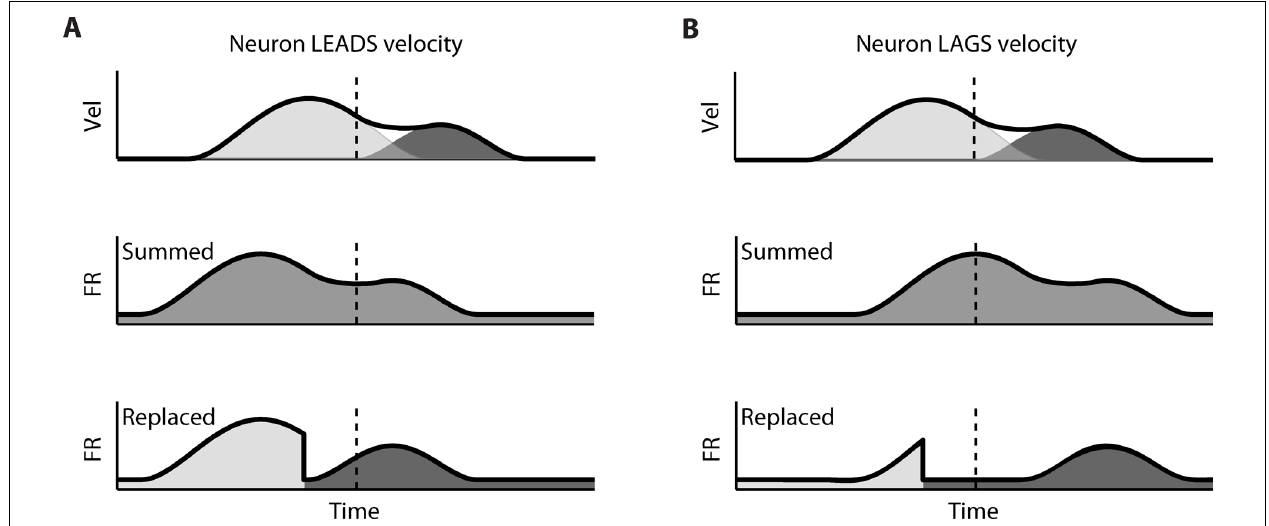
will track the primary velocity profile (light gray), before replacing this with coding of the secondary profile (dark gray). (B) The predictions under the “Summed” and “Replaced” hypotheses if neuronal firing instead lags the observed velocity.The replacement between coding of the primary and secondary movements is assumed to happen at a fixed delay that we call the neural offset , prior to the start of the second movement (dashed